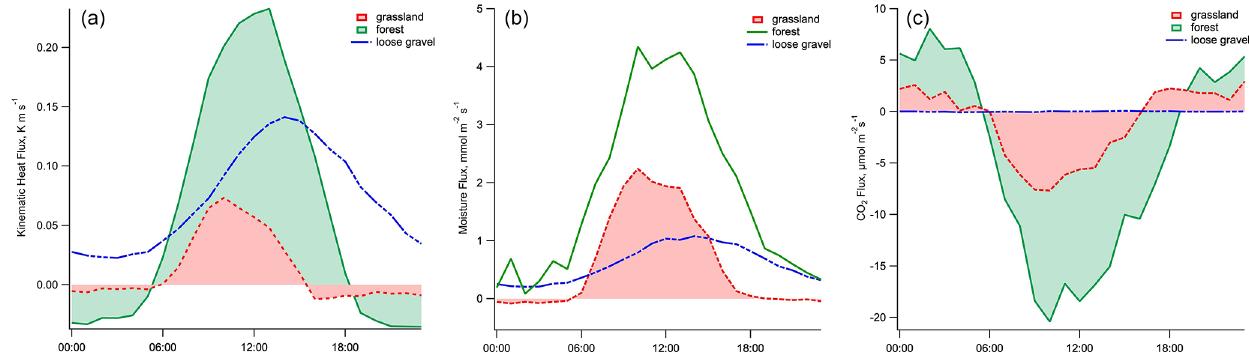
Figure 2. Ensemble-averaged diurnal fluxes of kinematic heat flux (a) , moisture flux (b) , and CO 2 flux (c) at each of the three sites. The traces where the sign of the flux changes are filled to the zero line for